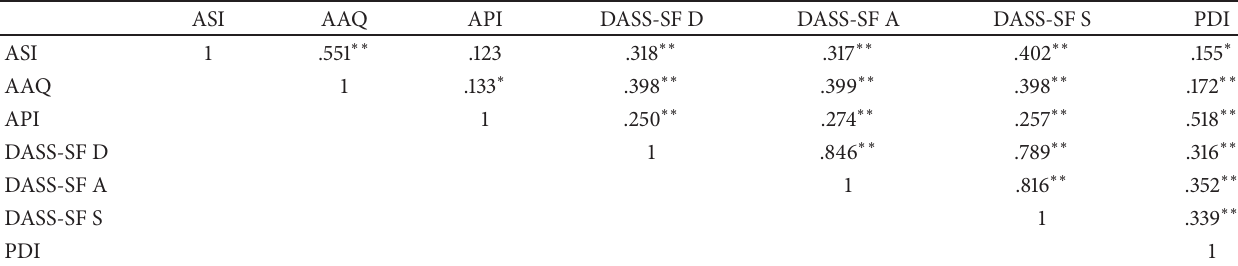
Table 1: Bivariate Pearson correlation matrix of measures at baseline.